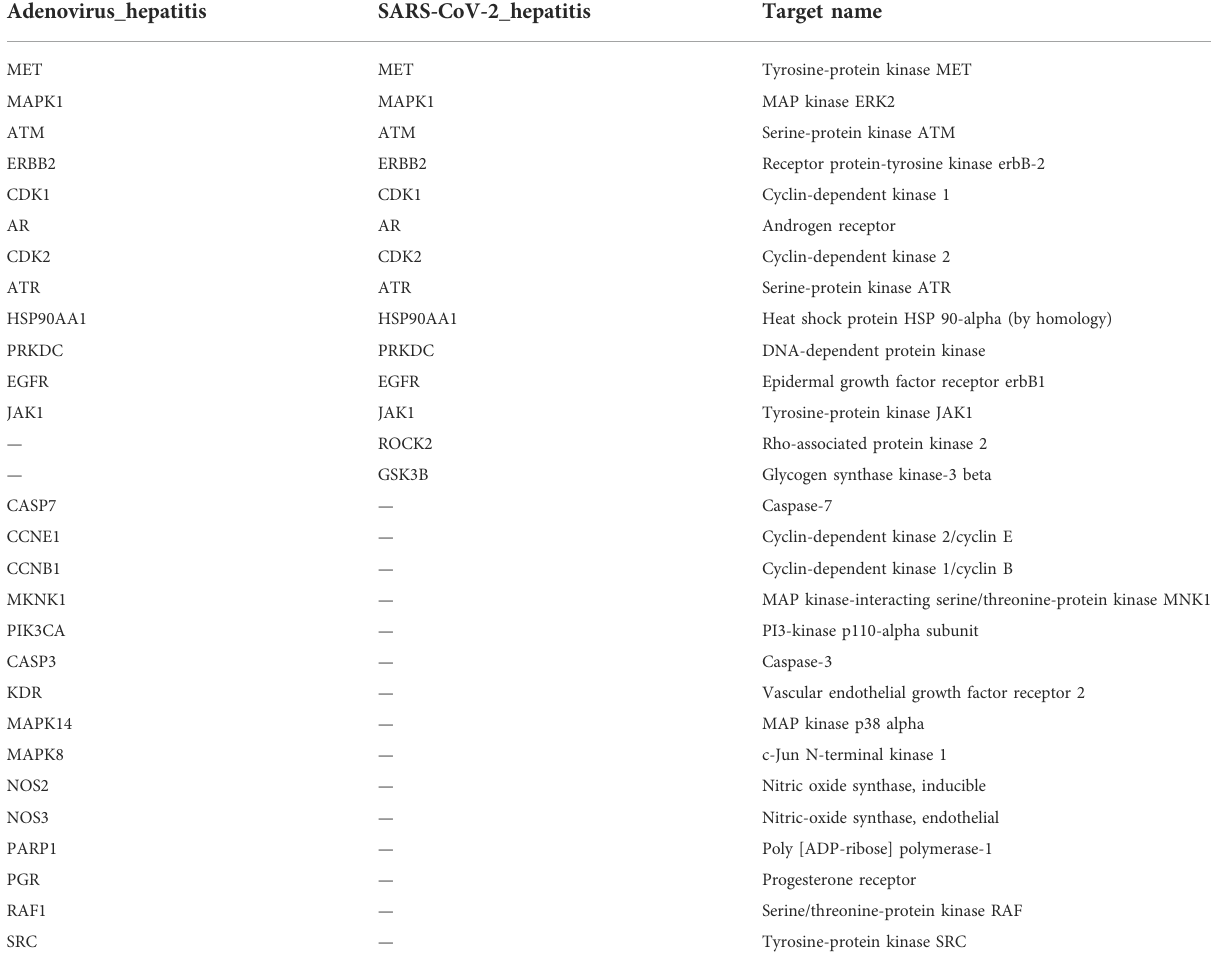
TABLE 1 Comparison of Schisandrin B (SchB) targets on adenovirus/SARS-CoV-2_hepatitis. Adenovirus_hepatitis SARS-CoV-2_hepatitis